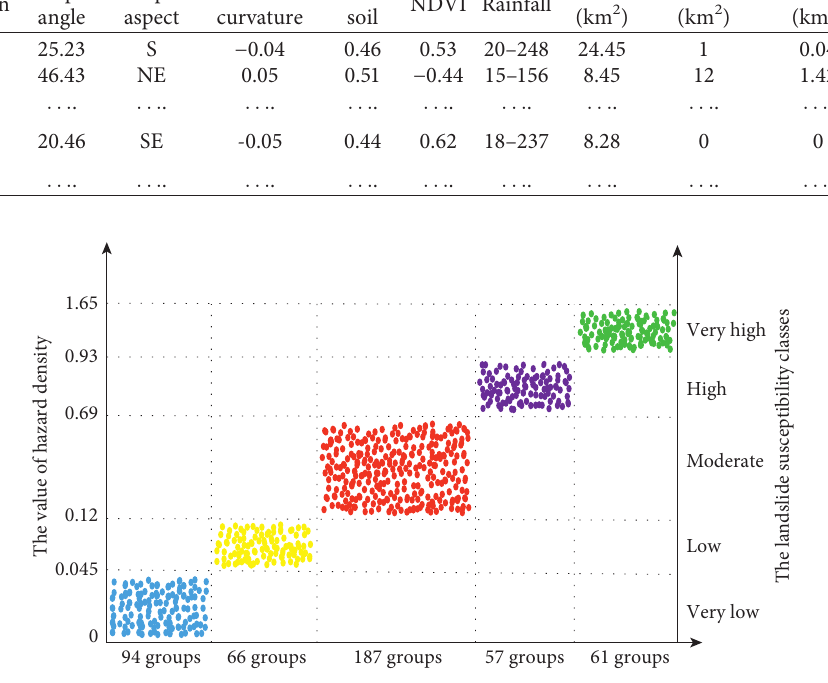
Table 3: Eigenvalue and landslide density of group based on the CA-AQD algorithm in July. Eigenvalue (have not been Number of groups